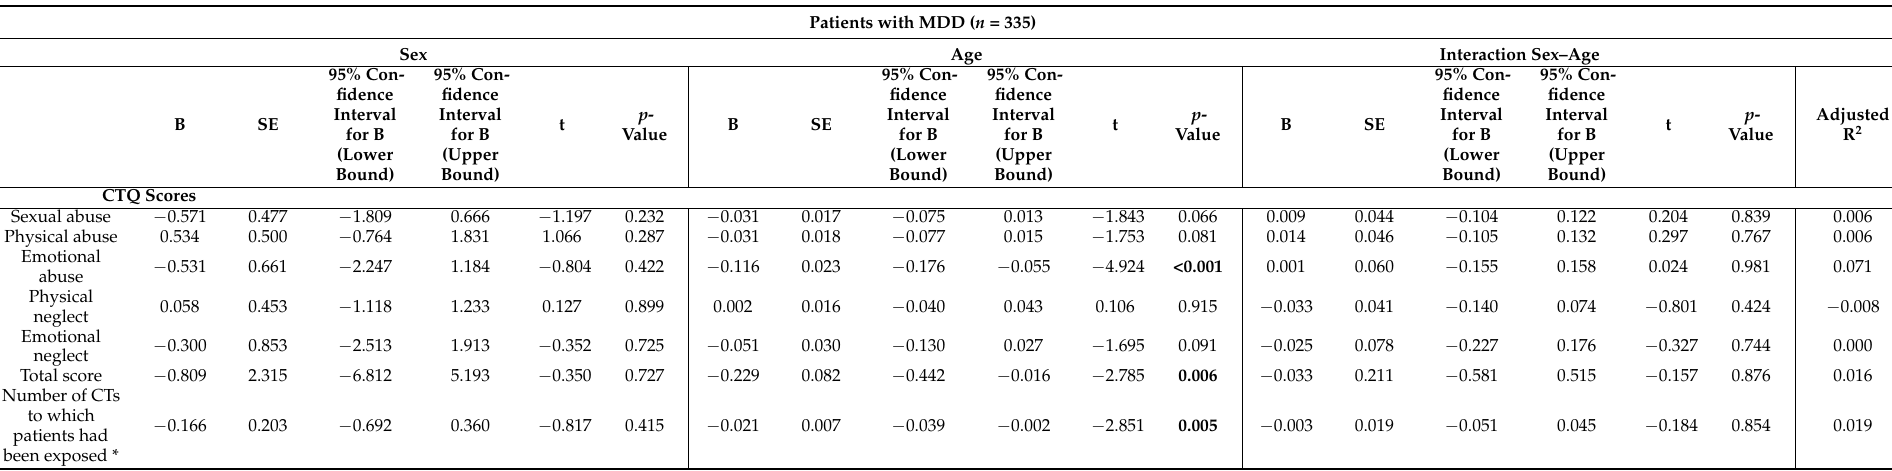
Table 2. Linear regression analysis in patients with